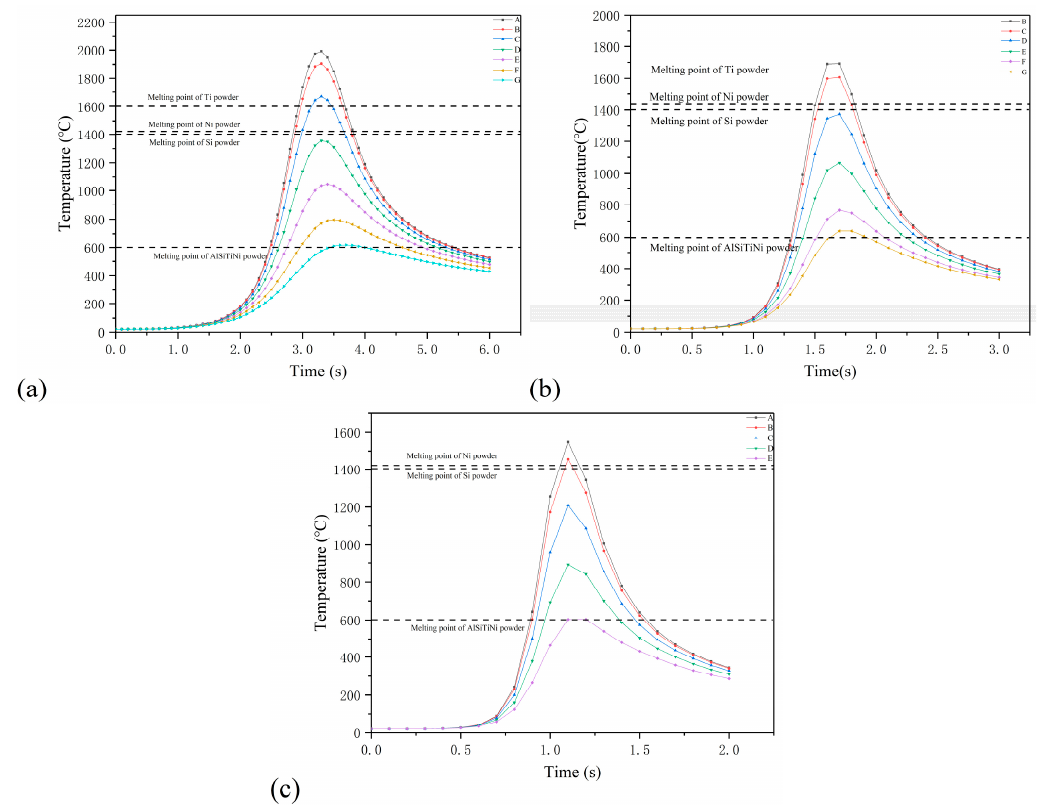
Figure 12. Time-history temperature curves of the monitoring point in the width direction of the molten pool: ( a ) 0.005 m/s, 1500 W, 6 s; ( b ) 0.01 m/s, 1500 W, 3 s; and ( c ) 0.015 m/s, 1500 W, 2 s.